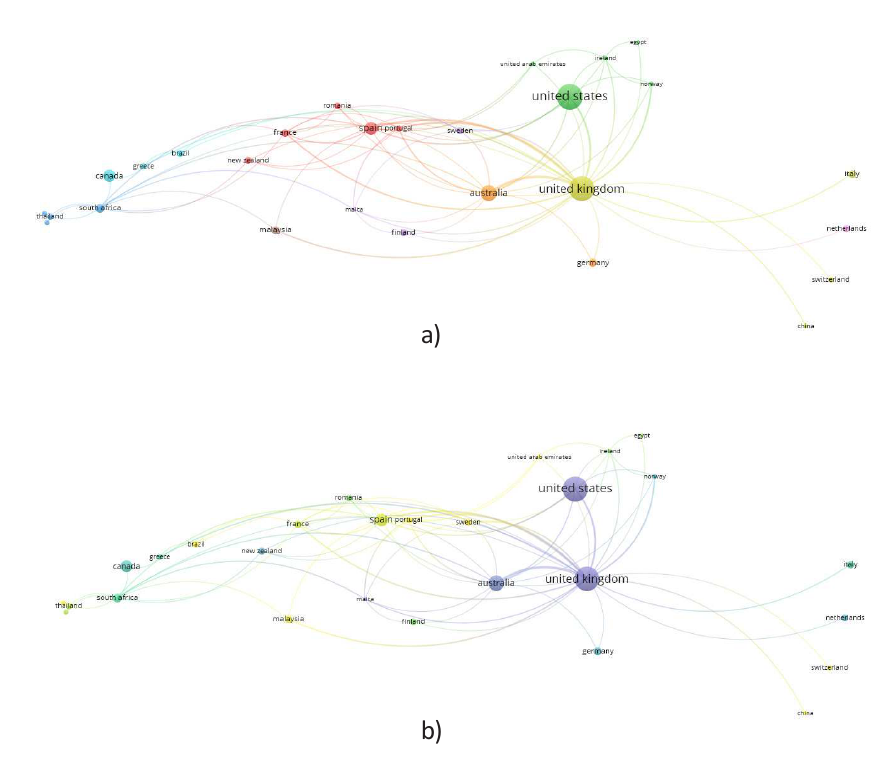
Figure 5. Overlay visualization map of countries’ co-authorship measurement of research on public service marketing according to the Scopus database